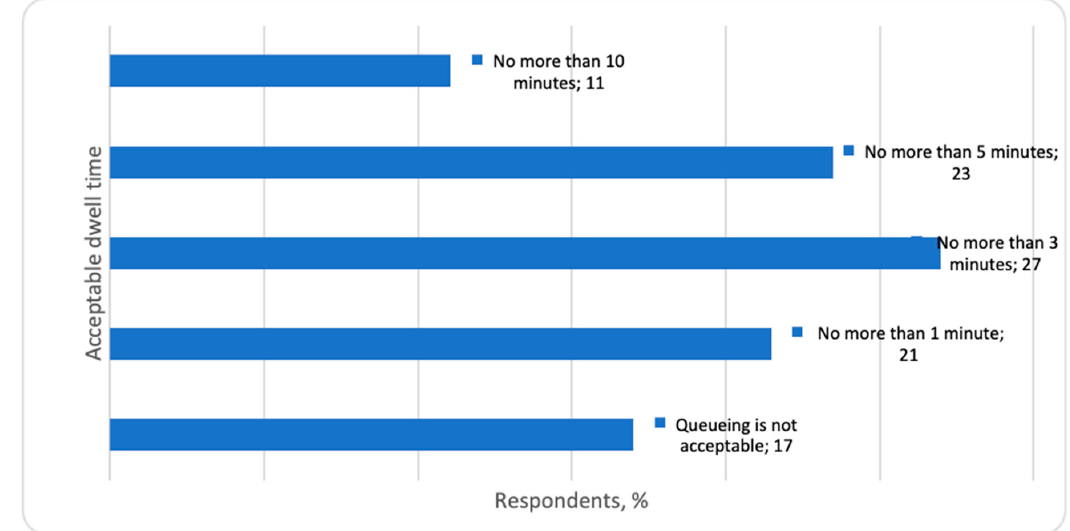
Figure 6. Acceptable dwell time at the station entrance/exit.